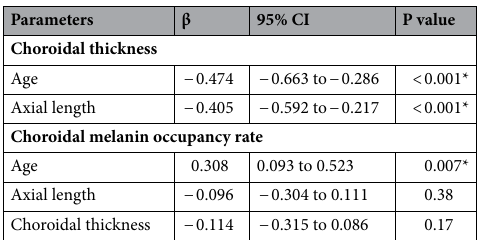
Table 2. Summary of stepwise multiple linear regression analysis of choroidal thickness and choroidal melanin occupancy rate. CI confidence interval. *Statistically significant correlation.